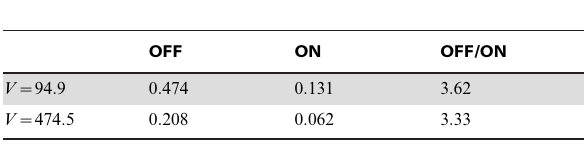
Relative fluctuations in each steady state for two different nondimensional cell volumes V for a ~ 2 : 13 for the multiplicative noise model. Relative fluctuations have been computed as the ratio between the standard deviation over the mean steady state. Standard deviations and mean values have been extracted from Langevin dynamics as in Fig. 2. As shown, relative fluctuations decrease with cell volume, but are always larger in the OFF state. The ratio between the relative fluctuations in the two states is indicated in the last column. This ratio is little sensitive to the cell volume.